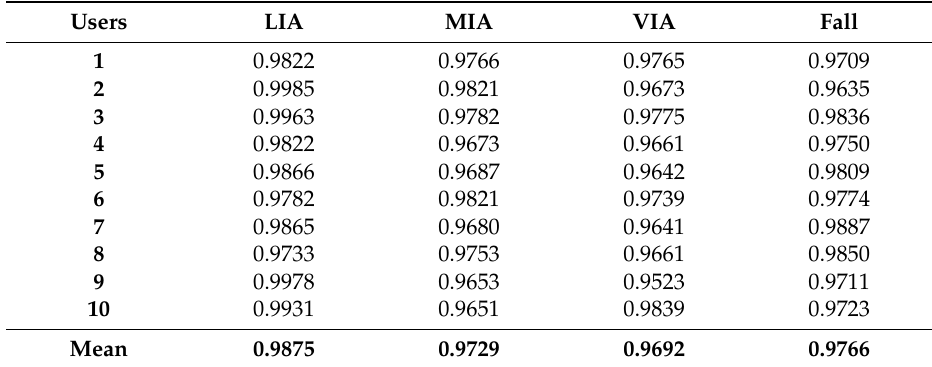
Table 3. F-measure of four recognized activity categories for our proposed algorithm. The last row presents the average values for all